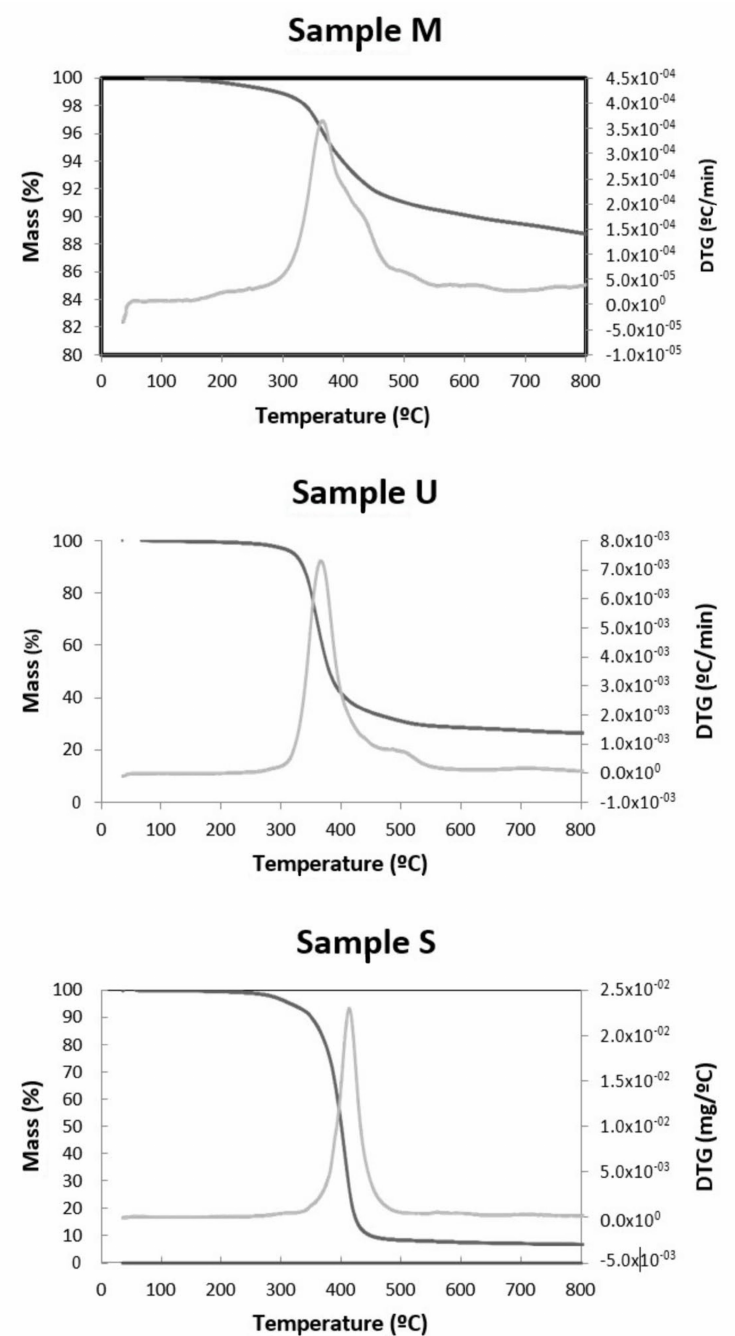
Figure 7. TG /DTG isotherms for the M, U and S samples, respectively. Other authors obtained similar results: Gaikwad et al. [15] reported that the toner lost about 60%wt when the temperature reached 1000 ◦ C. Dong et al. [46] found a similar behaviour; from about 270 ◦ C, it lost weight until about 500 ◦ C. From this temperature, the weight loss slowed down until 800 ◦ C, where it reached a maximum of 58%. Tests show that the amount of solid residue remaining after thermogravimetric analysis is very different from one sample to another because its original composition is very different from one commercial company to